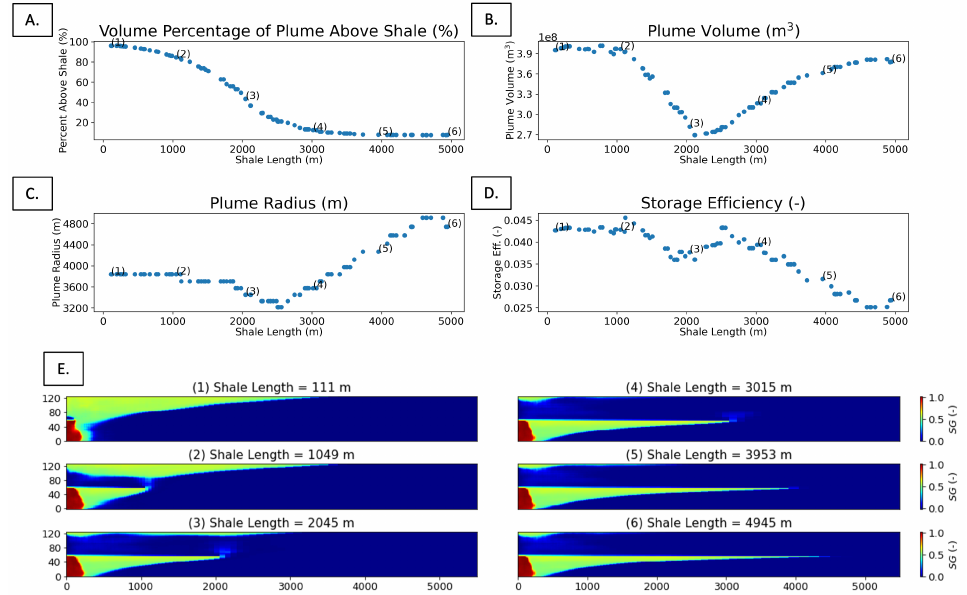
Figure 4. The impact of shale layer length on plume migration. ( A – D ) illustrate the relationship between four plume variables and the shale length. ( E ) shows the gas saturation map of six modeled cases (labeled in ( A – D